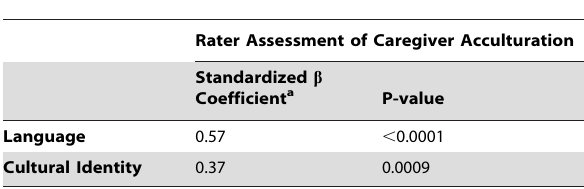
Table 4. Associations between rater assessment of caregiver acculturation and language and cultural identity